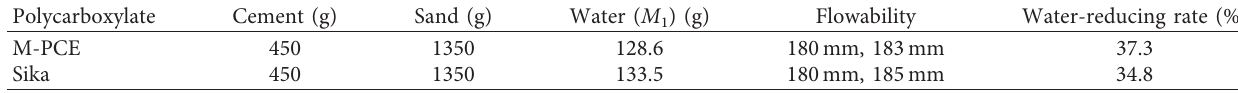
Table 3: Water reduction rate of polycarboxylate in mortar.